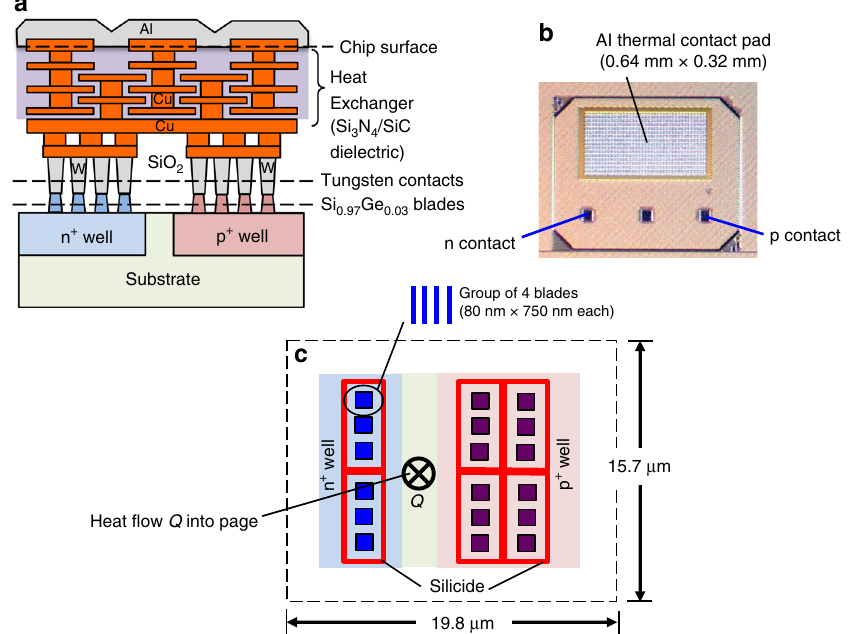
Fig. 2 Design of a harvest mode µ TEG. a Illustration (not to scale) of the side-view cross section through one n-p thermocouple with contact metallization and heat exchanger layers to a surface aluminum thermal contact pad. b Optical microscope plan view image of the Al coated thermal contact pad, with electrical contacts to the n and p sides of the thermopile array. (Middle contact pad is to the substrate and is not used.) c Plan view design (to scale) looking down on one thermopile unit cell forming the harvest mode µ TEG used to generate the data of Fig. 3. Each dark-colored solid square represents a group of four blade elements. The dark red lines are silicide electrical contacts to the n + and the p + wells. As depicted, the thermal contact would be above the page and the substrate behind the page, so heat Q fl ows perpendicularly into the plane of the page as indicated while electric current fl ows from n + well to p + well through the metal contacts bridging the n- and p-sides shown in part ( a